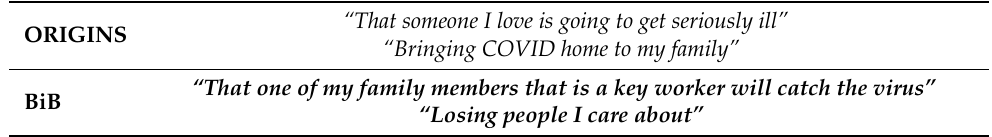
Table 2. Fear for family safety: Sample responses.